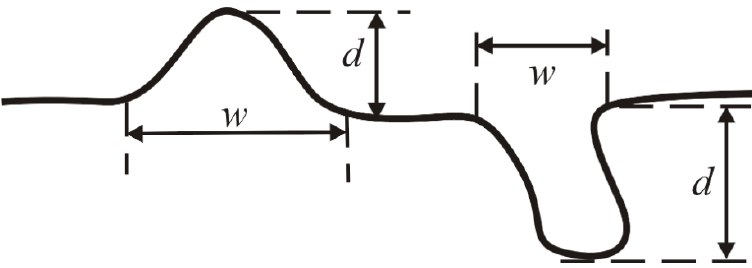
Figure 4. The schematic map of the width (w) and depth (d) of a bend.